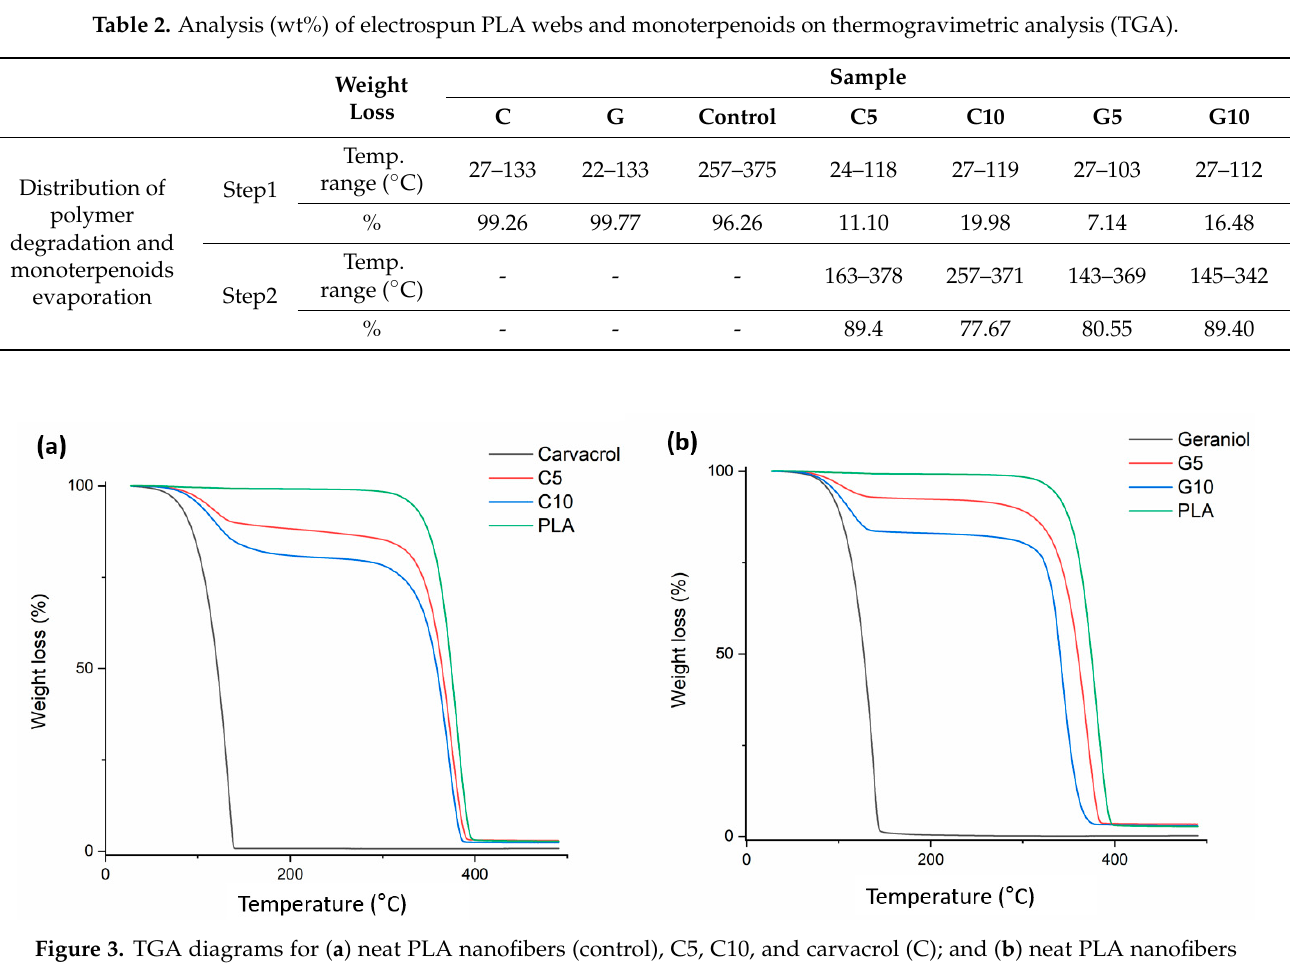
Figure 3. TGA diagrams for ( a ) neat PLA nanofibers (control), C5, C10, and carvacrol (C); and ( b ) neat PLA nanofibers (control), G5, G10, and geraniol (G).